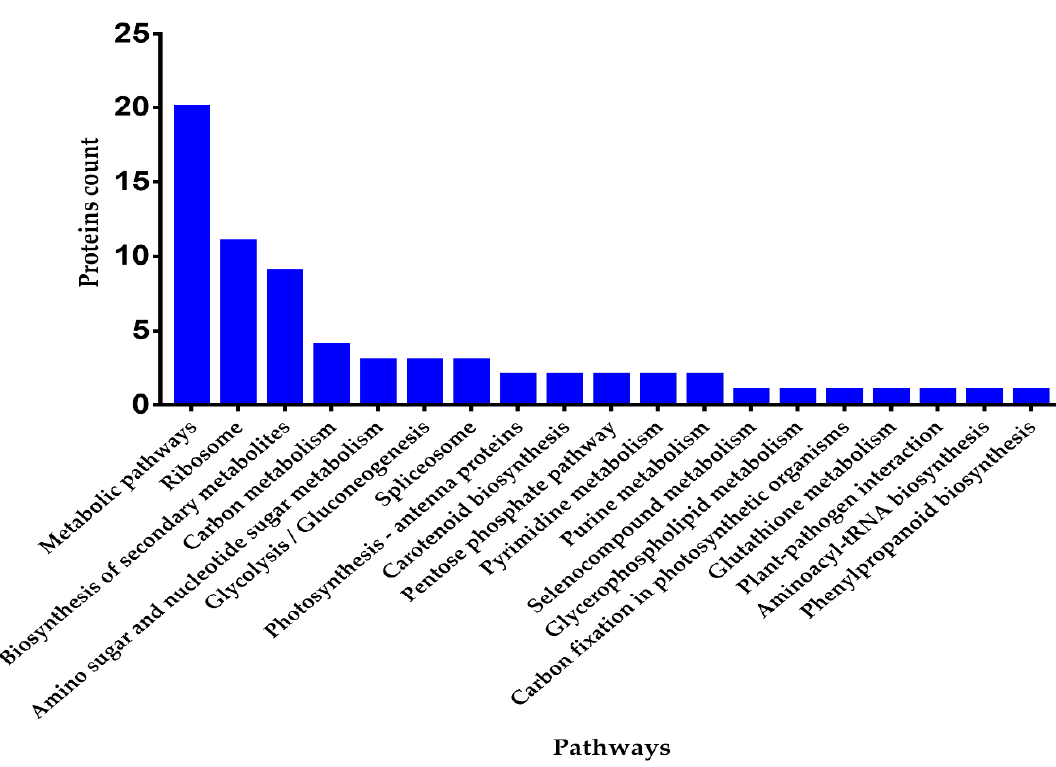
Figure 6. KEGG pathway enrichment histogram for up-regulated proteins ( p -value ≤ 0.05).